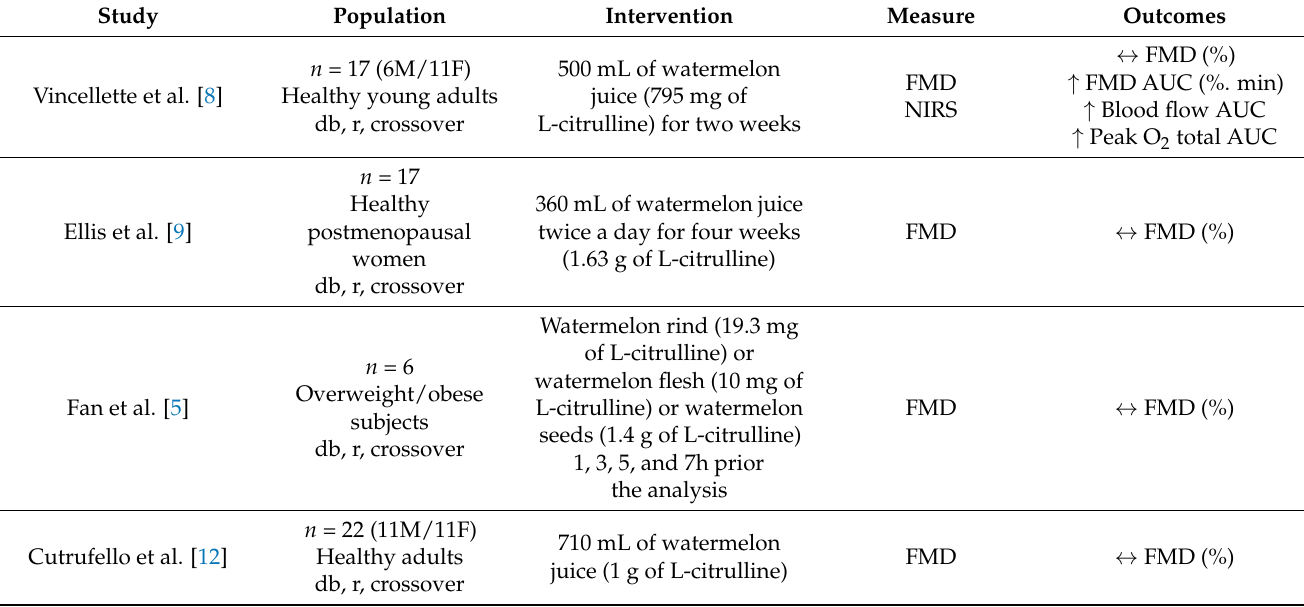
Table 1. Summary of the studies that evaluated the effect of watermelon ingestion on endothe- lial